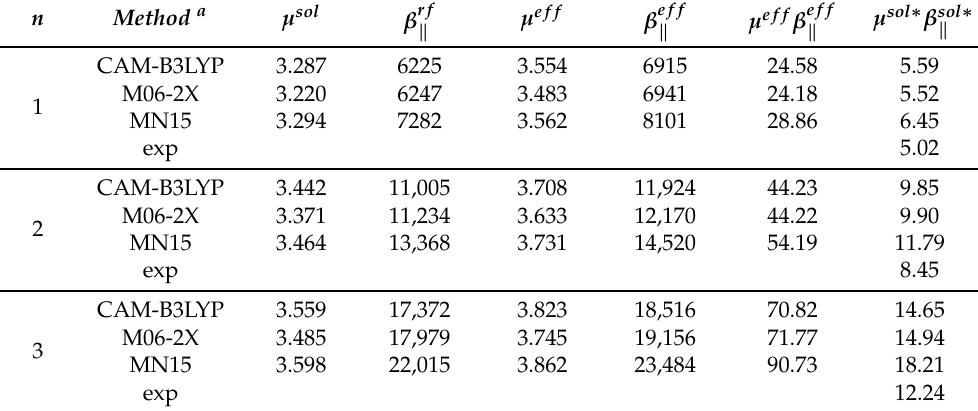
Table 3. Electronic contributions to total solute ( µ sol ) and effective dipole moment ( µ ef f ),